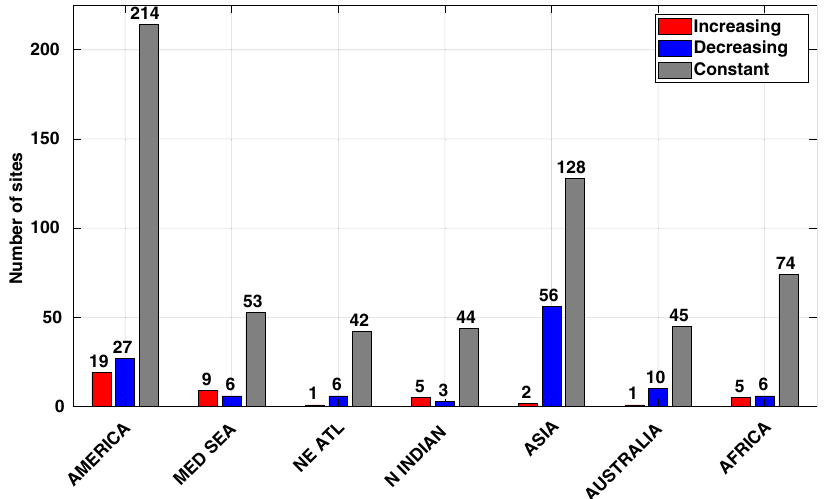
Fig. 6 Statistics of coastal trend behavior at the 756 virtual stations compared to 15 – 17 km offshore. Gray, red, and blue bars correspond to constant, increasing and decreasing coastal trends, respectively, depending on regions (America, Mediterranean Sea, Northeast Atlantic, North Indian Ocean, Asia, Australia, Africa).